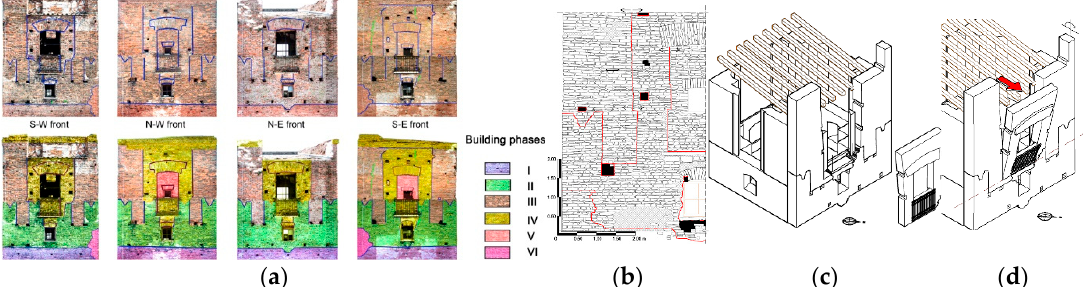
Figure 3. Supposed building phases: ( a ) Hypothesis about the evolution of the tower top (I) first building up to 46 m; (II) an addition up to the merlon level; (III) the adding of 4 corner piers supporting a for side roof; (IV) opening infilling and construction of the windows, crowning and the new roof; (V) the south corner repair [10]; ( b ) survey of the surface discontinuities; ( c ) mapping of unrestrained masonry portions and ( d ) hypothesis of possible cinematic mechanism during an earthquake.